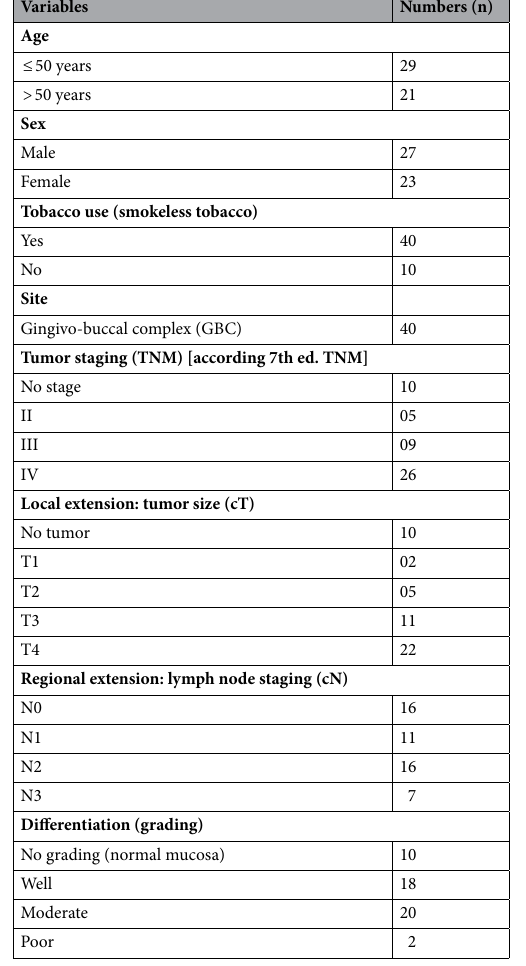
Table 3. Clinico-pathological features of samples of FSCN1 for Immunohistochemistry